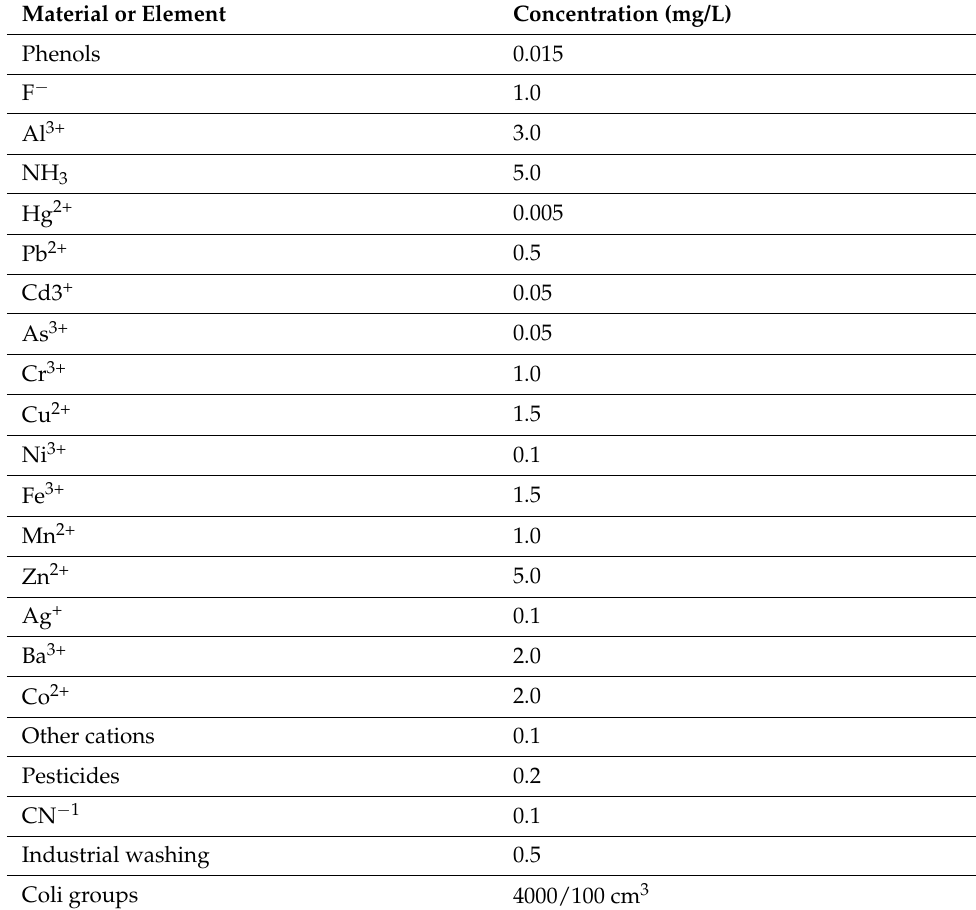
Table 2. The chemical composition of the sewage water (third treated stage) electrolyte used for H 2 generation